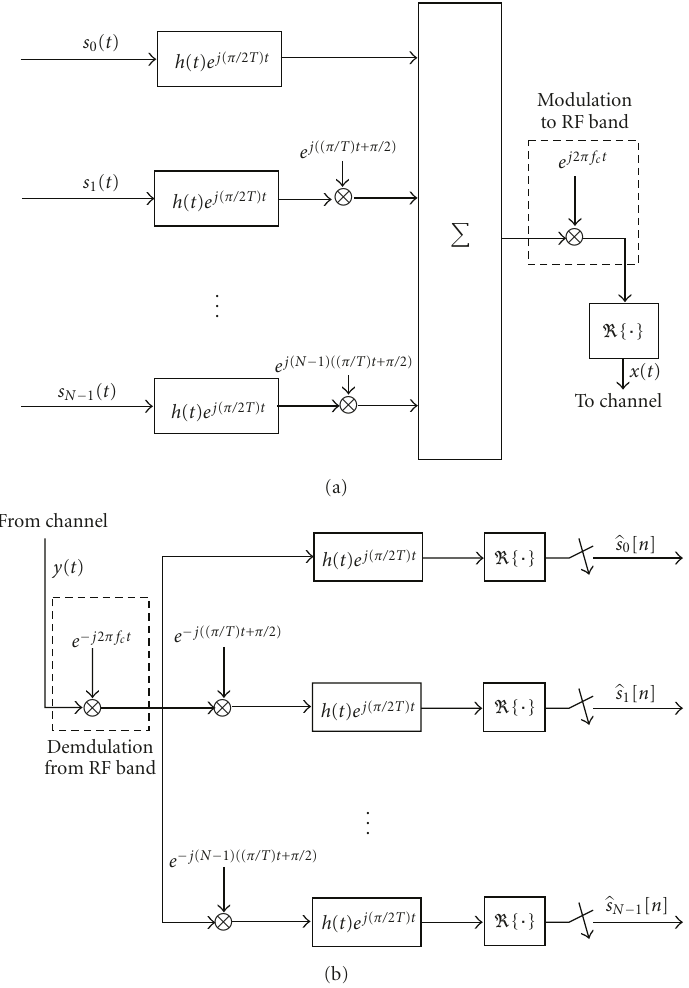
Figure 4: Block diagram of a CMT transceiver: (a) transmitter; (b)